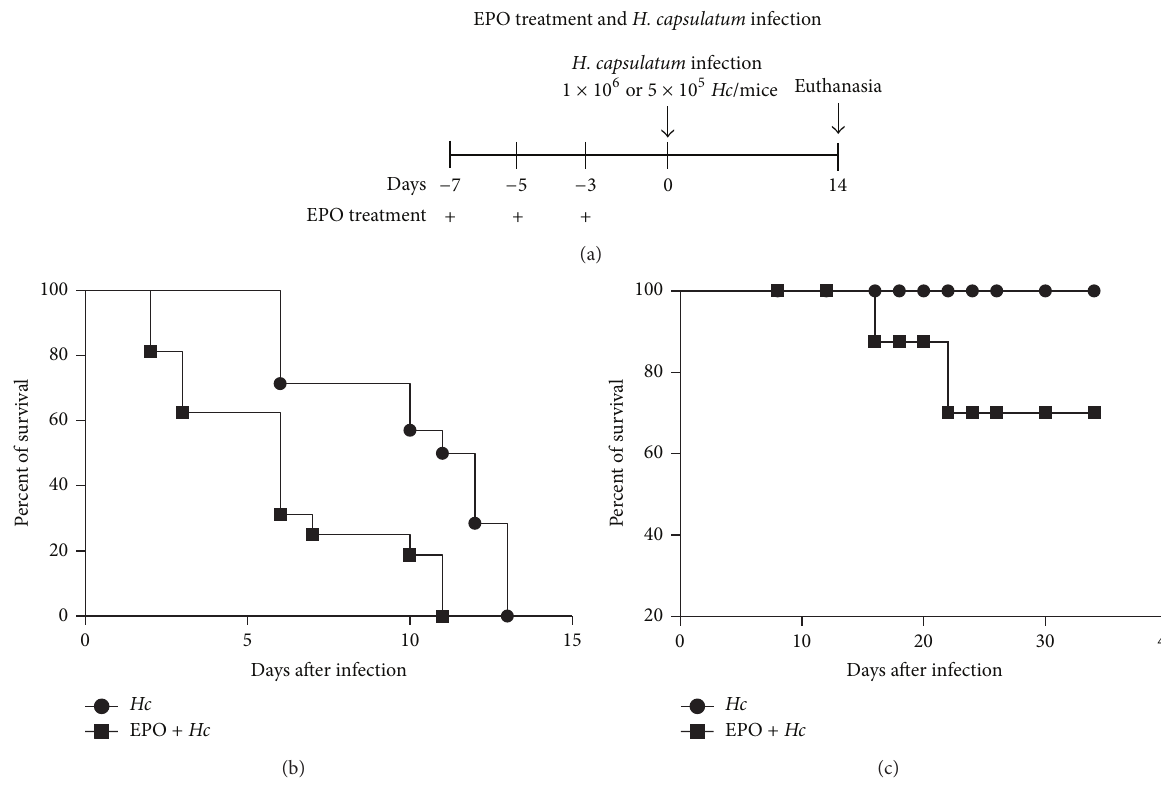
Figure 1: EPO pretreatment decreases the survival of Hc -infected mice. (a) Schematic representation of EPO treatment. In all experiments mice were treated with 45 U EPO three times per week, one week before Hc infection with (b) lethal (1 × 10 6 yeasts/100 𝜇 L/mouse) or (c) sublethal (5 × 10 5 yeasts/100 𝜇 L/mouse) (i.t.). Survival was followed up to 15 or 35 days, as indicated ( 𝑛 = 7 ). The log-rank test was used and differences were considered significant when 𝑝 < 0.05